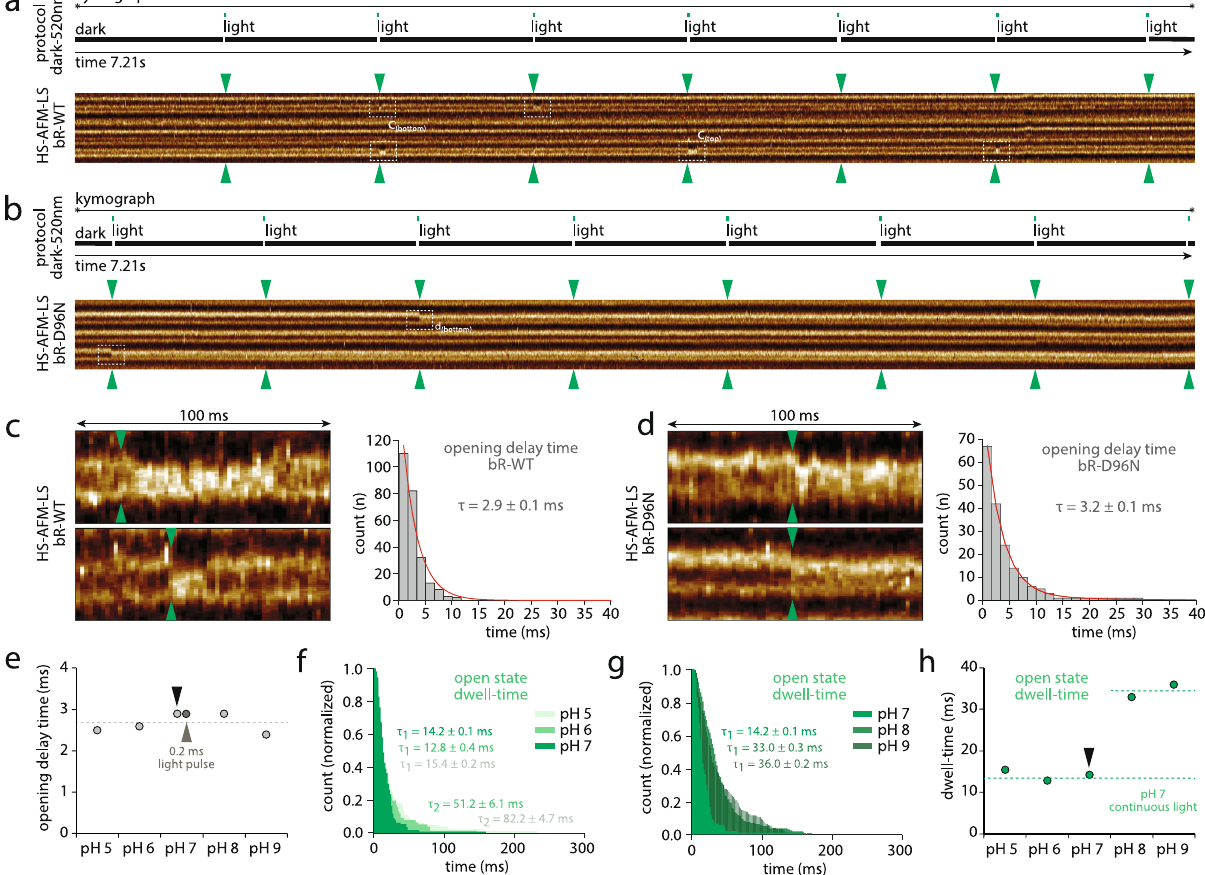
Fig. 3 Time delay between photoactivation and opening of the cytoplasmic gate. Top: Light protocol, and bottom: kymographs of ( a ) bR-WT, and ( b ) bR- D96N, in response to short activation light pulses (one 0.5 ms-pulse every second). The green arrowheads indicate the time of the activation light pulses. The white dashed outlines highlight bR protomer opening. Left: Raw data display of 8 nm scan dimension and 100 ms kymograph of the conformational changes occurring in individual ( c ) bR-WT, and ( d ) bR-D96N, protomers (see white dashed outlines in a and b ). Right: Opening delay time distribution for ( c ) bR-WT with τ delay-WT = 2.9 ± 0.1 ms ( n = 110), and ( d ) bR-D96N with τ delay-D96N = 3.2 ± 0.1 ms ( n = 67). e τ delay of bR-WT at pH 5, pH 6, pH 7, pH 8 and pH 9. Black arrowhead indicates the data point from c . Gray arrowhead indicates the data point from experiments with 0.2 ms-pulses. f Dwell-times of the open state at pH 5, pH 6, and pH 7. First component exponential fi ttings give open state dwell times of τ open-1(pH5,pH6,pH7) = ~14 ms (as indicated). Second exponential fi ttings for pH5 and pH 6 give τ open-2(pH5) = 82.2 ± 4.7 ms and τ open-2(pH6) = 51.2 ± 6.1 ms. g Dwell-times of the open state at pH 7, pH 8 and pH 9 (as indicated). h τ open-1 of bR-WT at pH 5, pH 6, pH 7, pH 8 and pH 9. Dashed line (bottom) indicates the open state dwell time obtained at pH 7 under continuous light conditions (see Fig. 2g, bottom). Dashed line (top) indicated the average value at pH 8 and pH 9. Note that at acidic pH 5 and pH 6, ~10% of the molecules adopt a long activate state with τ open-2(pH5,pH6) = ~60 ms. n is the total number of events analyzed. τ denotes dwell-time as the fi t of the single exponential fi t, y ð x Þ ¼ Ce (cid:2) x = τ , for pH > 7, and double exponential fi ts, y ð x Þ ¼ C 1 e (cid:2) x = τ 1 þ C 2 e (cid:2) x = τ 2 , for pH 5 and